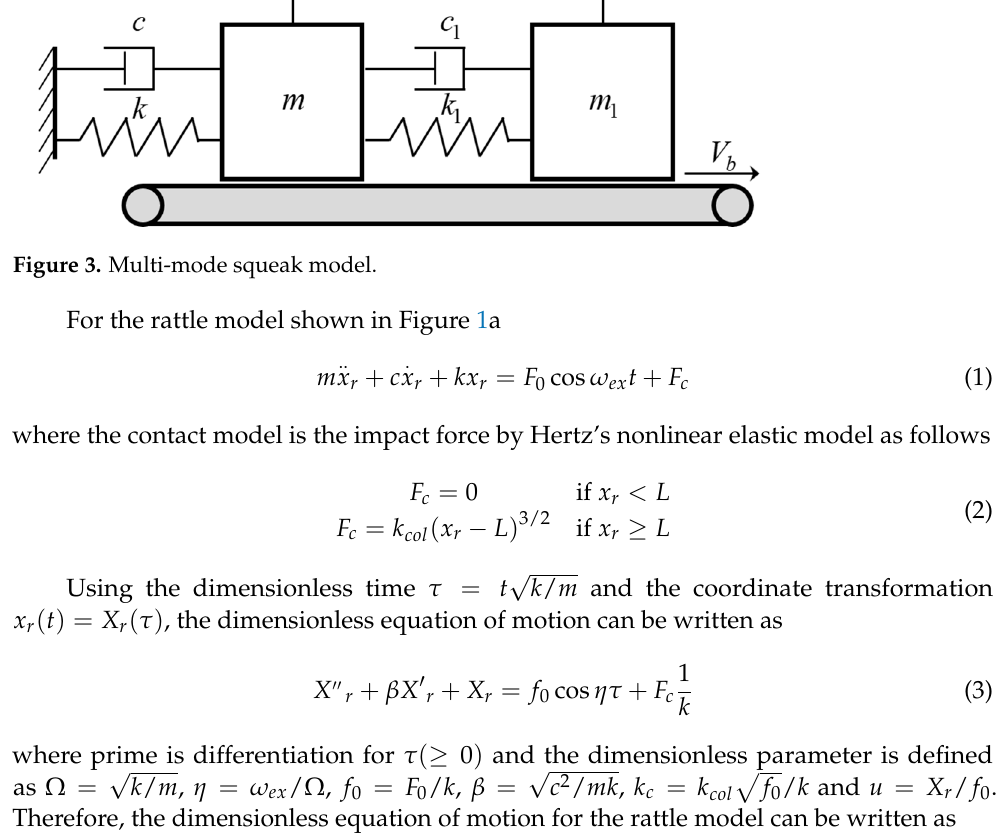
Figure 2. Single-mode squeak model: ( a ) 1-D model ( b ) friction–velocity curve.